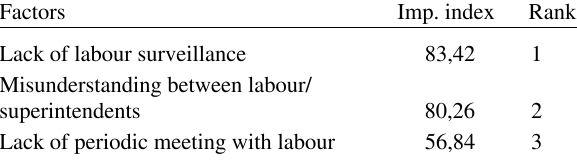
Table 2. Ranking factors under leadership group